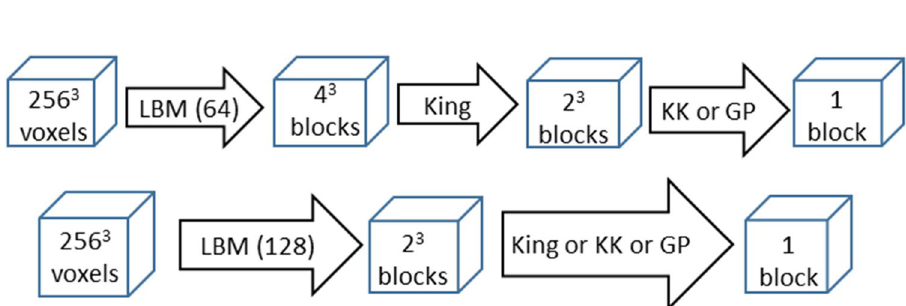
Fig. 6 Processes of combination of LBM and RGA (top: LBM was applied to blocks with the size of 64 3 voxels; bottom: LBM was applied to blocks with the size of 128 3